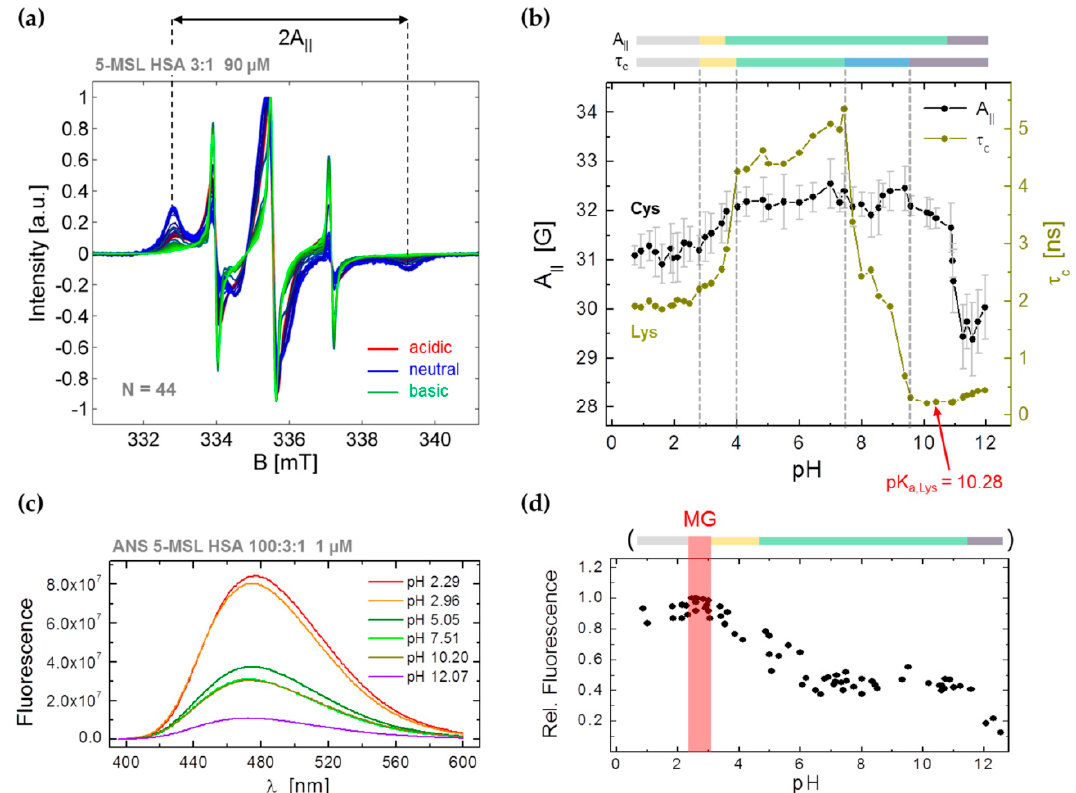
Figure 2. pH ‐ dependent CW EPR and fluorescence experiments on 5 ‐ MSL HSA. ( a ) CW EPR spectra of N = 44 different 5 ‐ MSL HSA solutions between 0.72 < pH < 11.96 are shown. The black dotted lines indicate the apparent hyperfine coupling constant (2 A || ). All spectra are here color coded in red (acidic), blue (neutral, or compact) and green (basic). ( b ) Apparent hyperfine coupling constants A || (black) and the collective rotational correlation times τ c (dark yellow) are shown together as functions of pH from CW EPR spectra in ( a ). The different regions in the τ c curve can be subdivided into five dynamic regimes according to Qiu et al. [53] displaying the extended (E, gray), fast migrating (F, yellow), norm (N, green), basic (B, blue) and aged (A, purple) form of HSA. Phase space bars are given for τ c and A || where a compact form (C, green) was identified that ranges from pH 3.7–10.9. The collective lysine p K a value (p K a,Lys = 10.28 (red)) was calculated, as shown in Supplementary Material S3. All CW EPR measurements on 5 ‐ MSL HSA were performed at a protein concentration of 90 μ M ( ≈ 280 μ M MSL). ( c ) ANS fluorescence of 5 ‐ MSL HSA and ( d ) relative fluorescence values (black dots) are given in the pH range of pH 0.9–12.5. The molten globule (MG, red) appears where ANS fluorescence has its maximum between about pH 2.3 and 3.1. All fluorescence experiments were performed at a protein concentration of 1 μ M and 100 μ M of ANS (100 eq).